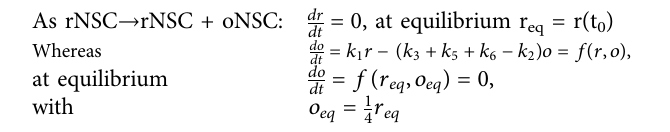
IgG Alexa Fluor 594 (ab150084, Abcam), goat polyclonal